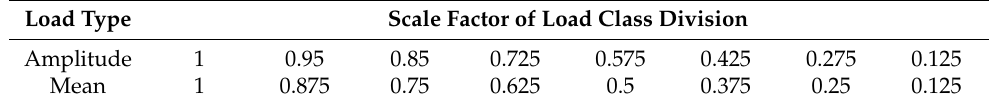
Table 2. Scale factor for the grade division of load cycle amplitude and mean.